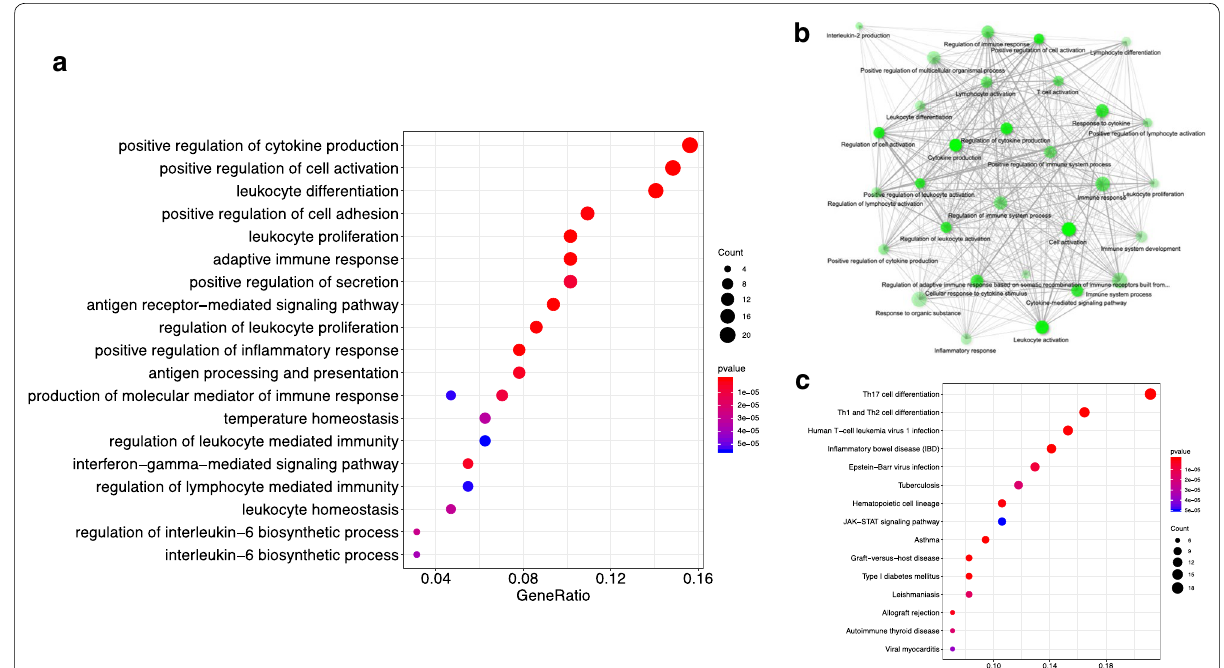
Fig. 4 Functional annotation of the genes corresponding to the SNPs that were significantly associated with asthma/AR in GWASs. We used the whole list of SNPs (Ensemble codes) shown in the Additional file 1: Table S1. Of these, only SNPs that were connected to protein coding genes were used in this analysis, and only one unique gene associated with one or several SNPs were used. Noncoding genes related to these asthma/AR ‑associated SNPs were excluded in functional annotation. The total number of genes of this functional annotation was 155 genes. a Gene ontology (GO) categories (functional protein categories) that were enriched. b Gene function network interaction of the GO‑categories. The network interaction shows strong interaction between the GO‑categories and indicating regulation functions between each other. c Kyoto Encyclopedia of Genes and Genomes (KEGG) pathways enriched among 155 genes. Shades of blue and red indicate significance of the enrichment (all were significant at level p < 0.05), and the size of the dot represents gene count. X‑axis represents the number of genes belonging to the particular category / total number of observed genes (N =